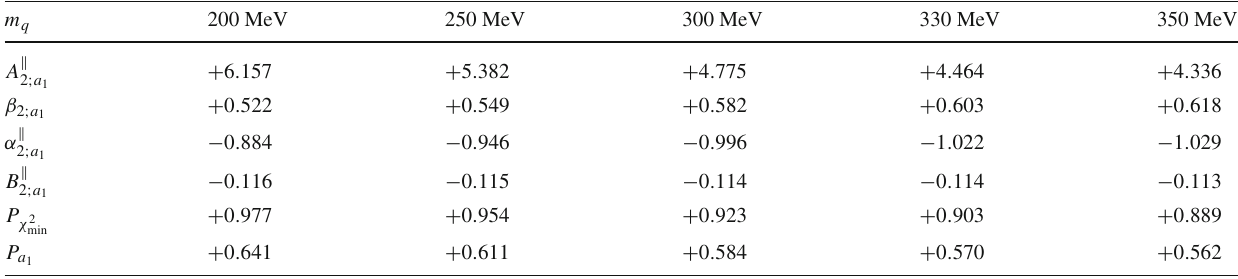
Table 2 Fitting parameters A the goodness of fit P